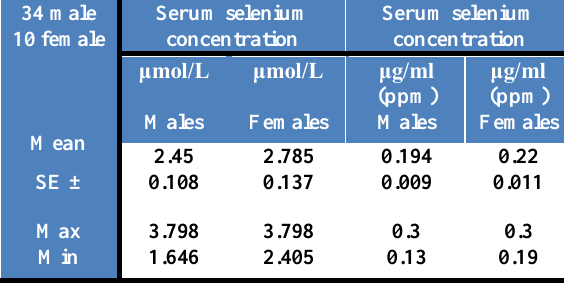
*There is no significant differences between males and females at the level (P≤